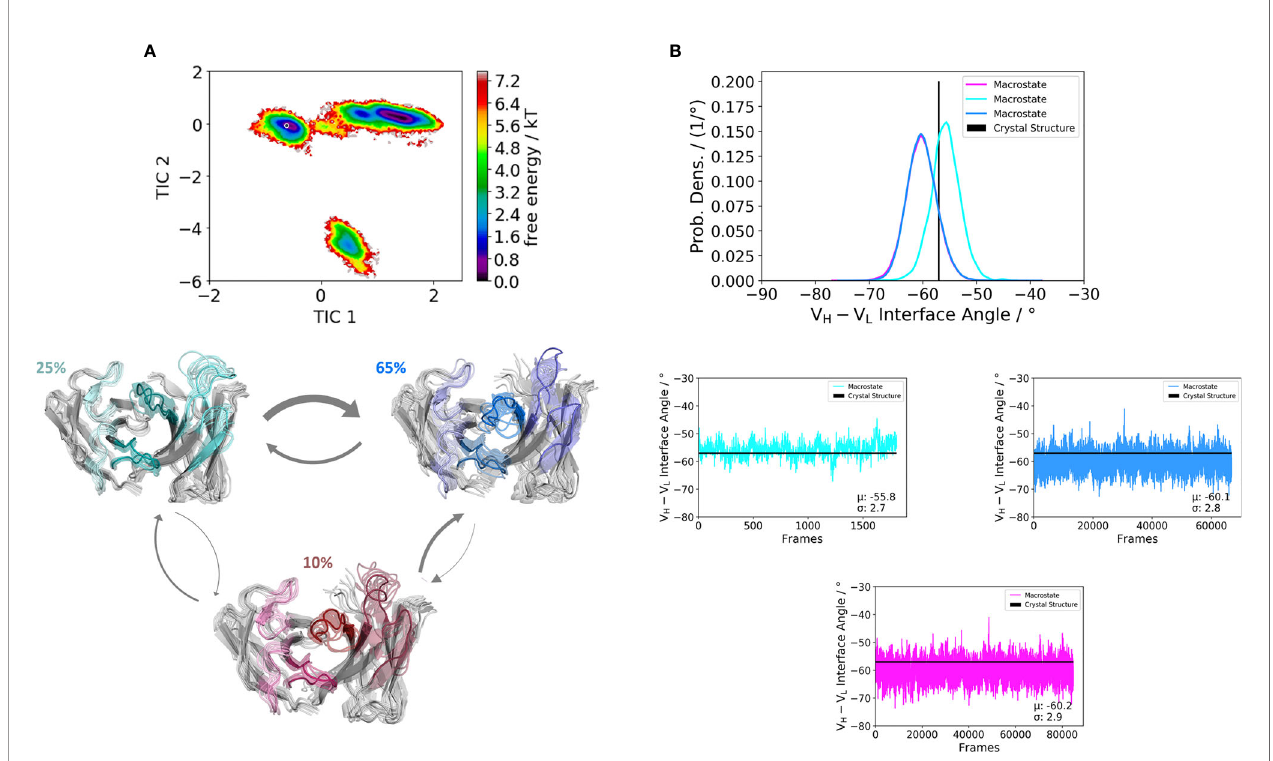
FIGURE 3 | Germline pairing speci fi c paratope states in solution for the H1-69:L1-39 (5I15) Fab. (A) Shows the resulting paratope states, the free energy landscape, the macrostate ensembles and the respective V H and V L orientations for the 5I15 antibody. The thickness of the arrows corresponds to the transition timescales. The ticker the arrows the faster the transition. The macrostate ensembles are arranged according to the shape of the tICA. (B) We also observe a signi fi cant shift in the interdomain angle distributions upon conformational changes in the paratope, which are visualized as probability density distributions. The starting X-ray structure for the underlying simulations is depicted as black dot in the free energy surfaces and as black line in the plots showing the V H -V L angle